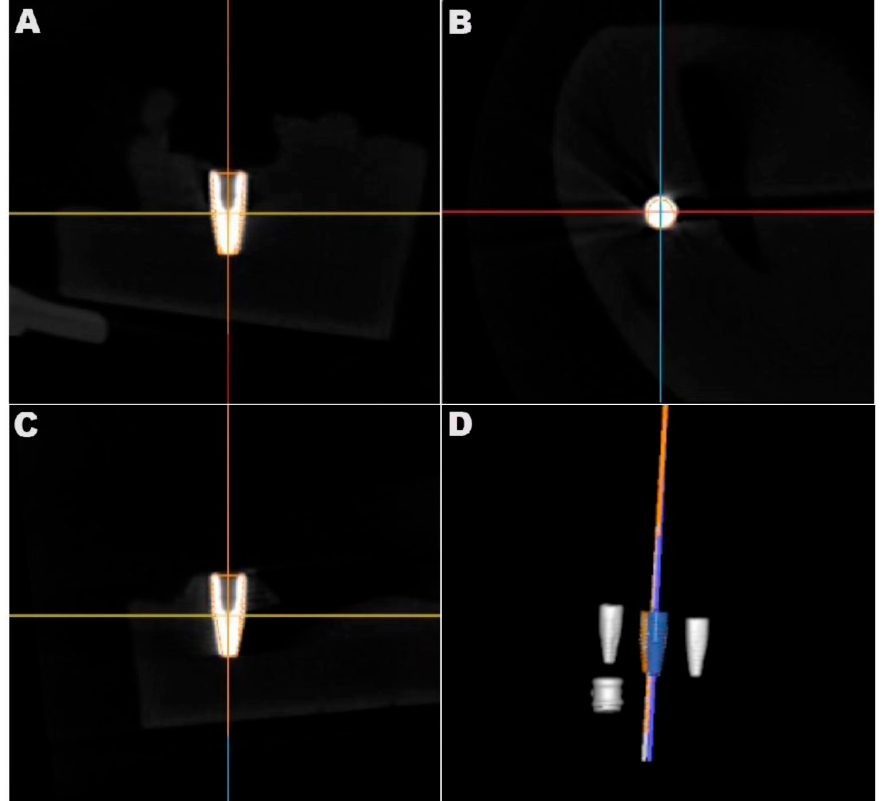
Figure 7. The reconstructed 3D images containing visible representations of the achieved implants generated by the DNS-based method (white implant in ( A – C ); blue implant in ( D )) were superim- posed on the postoperative CBCT dataset (orange line in ( A – C ); orange implant in ( D )) for accuracy evaluation. ( A ) Implant sagittal; ( B ) implant coronal; ( C ) implant axial; ( D ) 3D image.